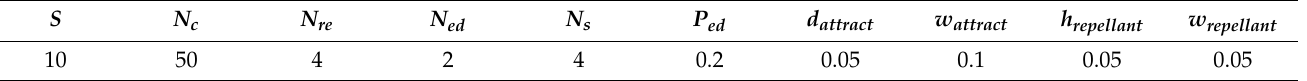
Table 2. Experimental parameter settings.